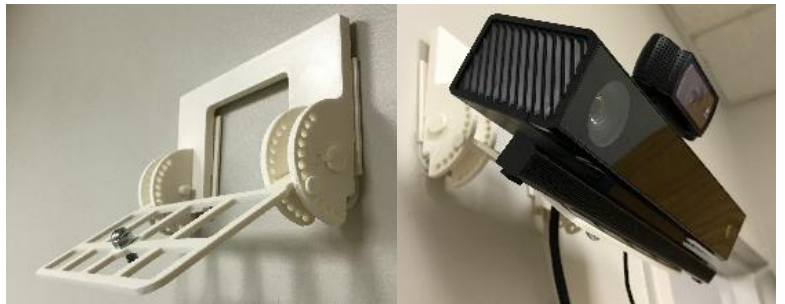
Figure 3. Kinect